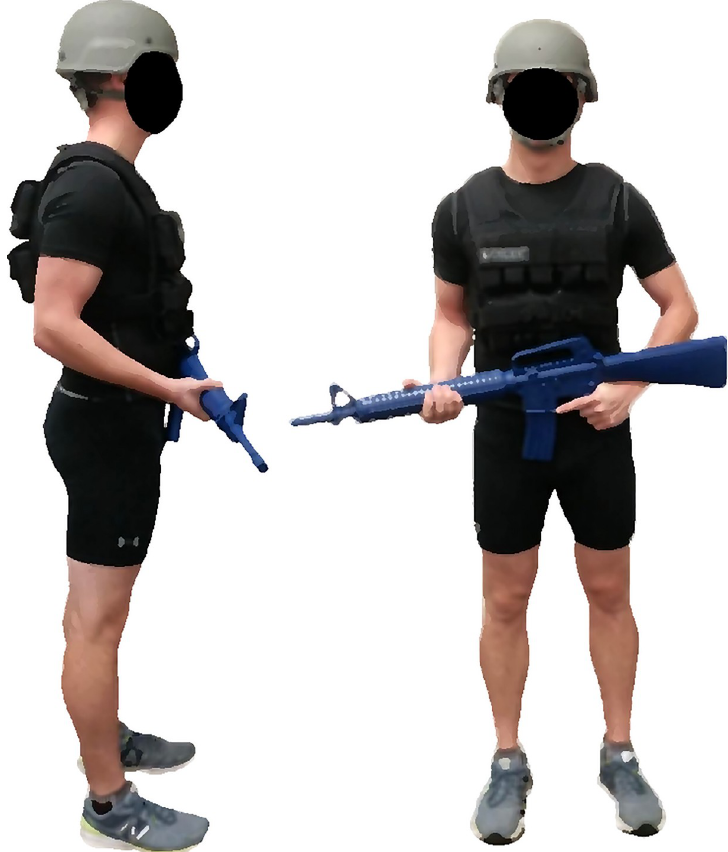
Fig 1. Body borne load